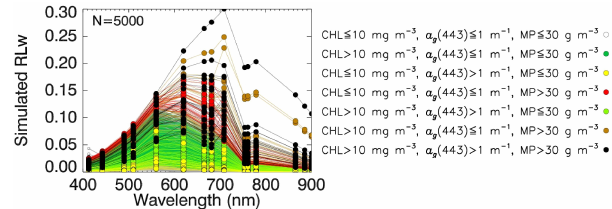
Figure 21. The simulated reflectance spectra in the CCRRv1. The colours represent the ranges of MP, CHL, and a g (443) as reported in the key